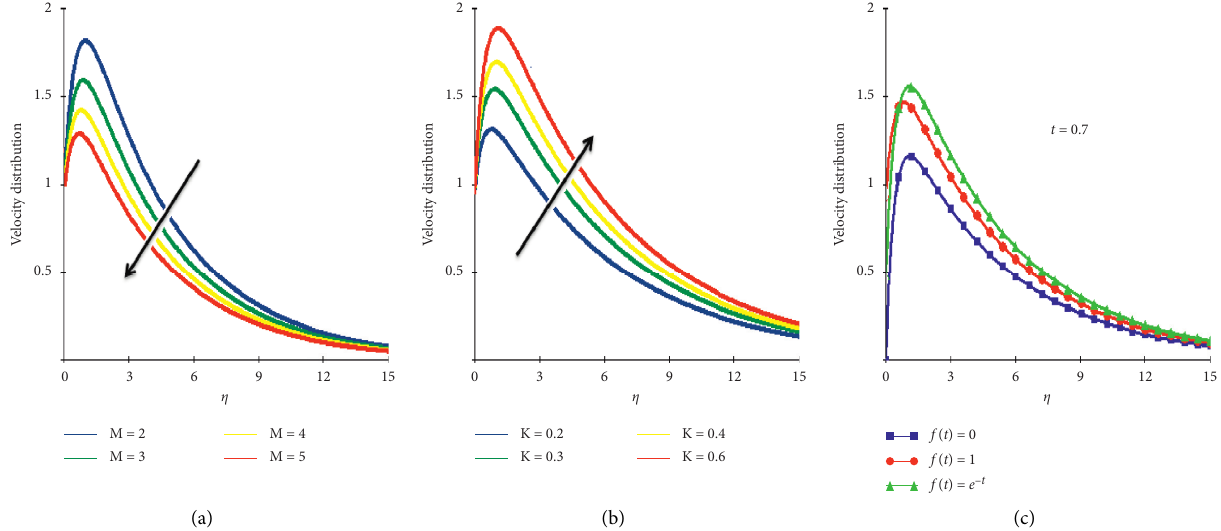
Figure 8: Sketch of velocity profile for changing values of M , K , and for f ( t )